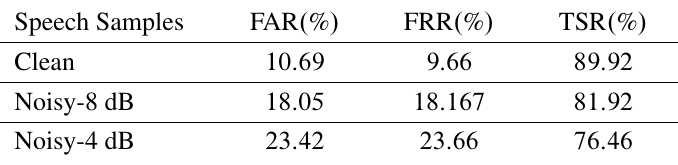
Table 3. Verification rate of speech system for clean and noisy samples.